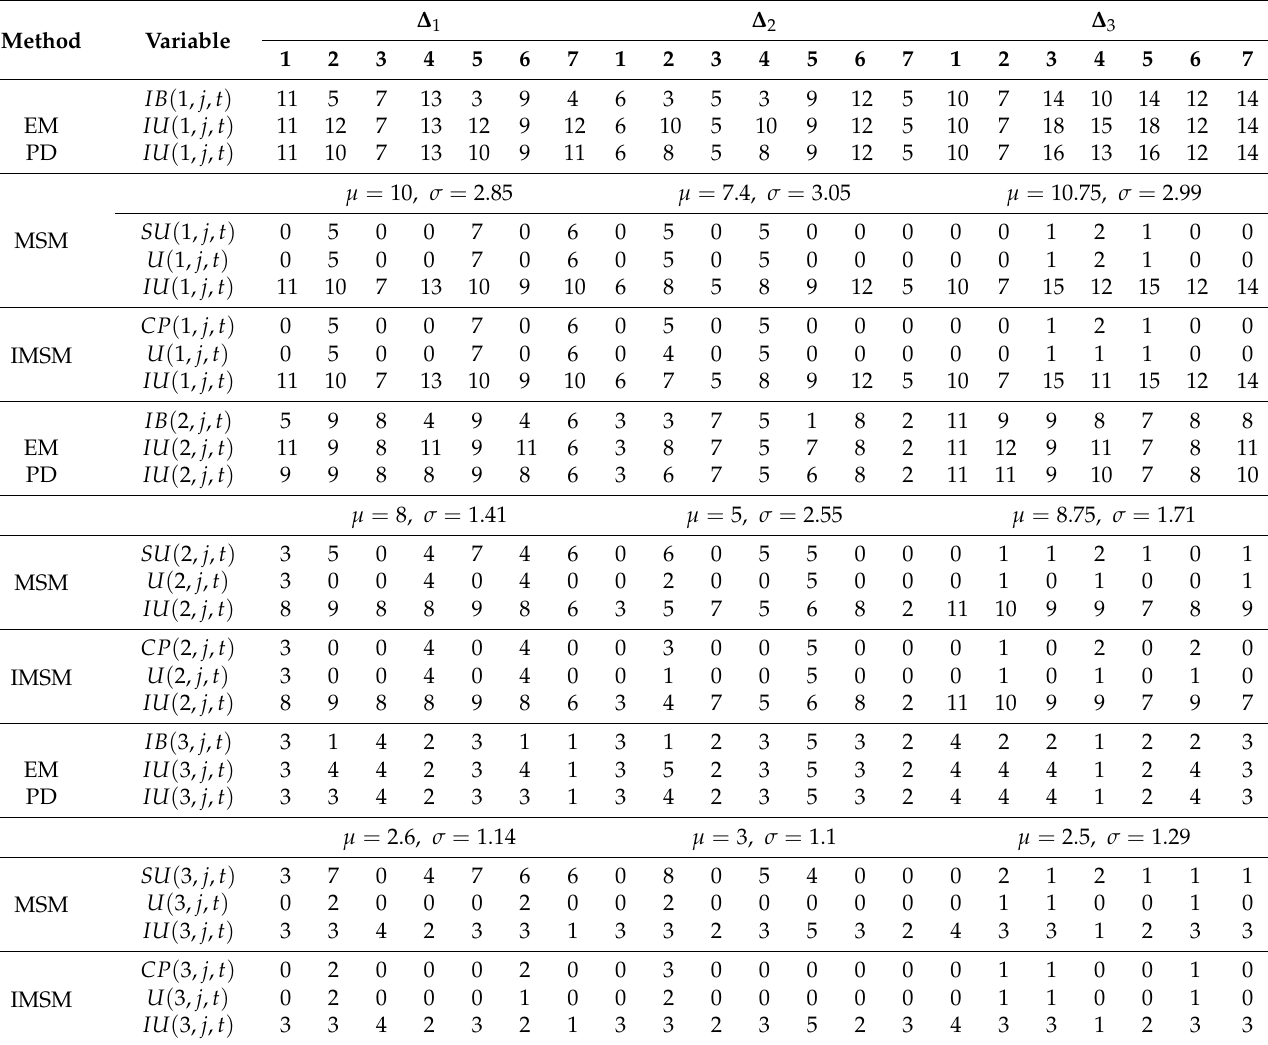
Table 7. Estimation results comparison of EM, PD, MSM, and